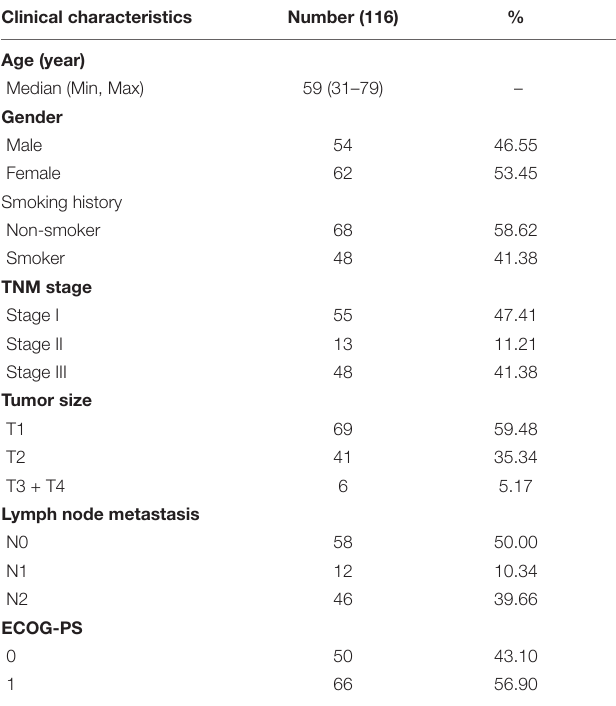
TABLE 2 | The clinical information of LUAD patients in validation set. Clinical